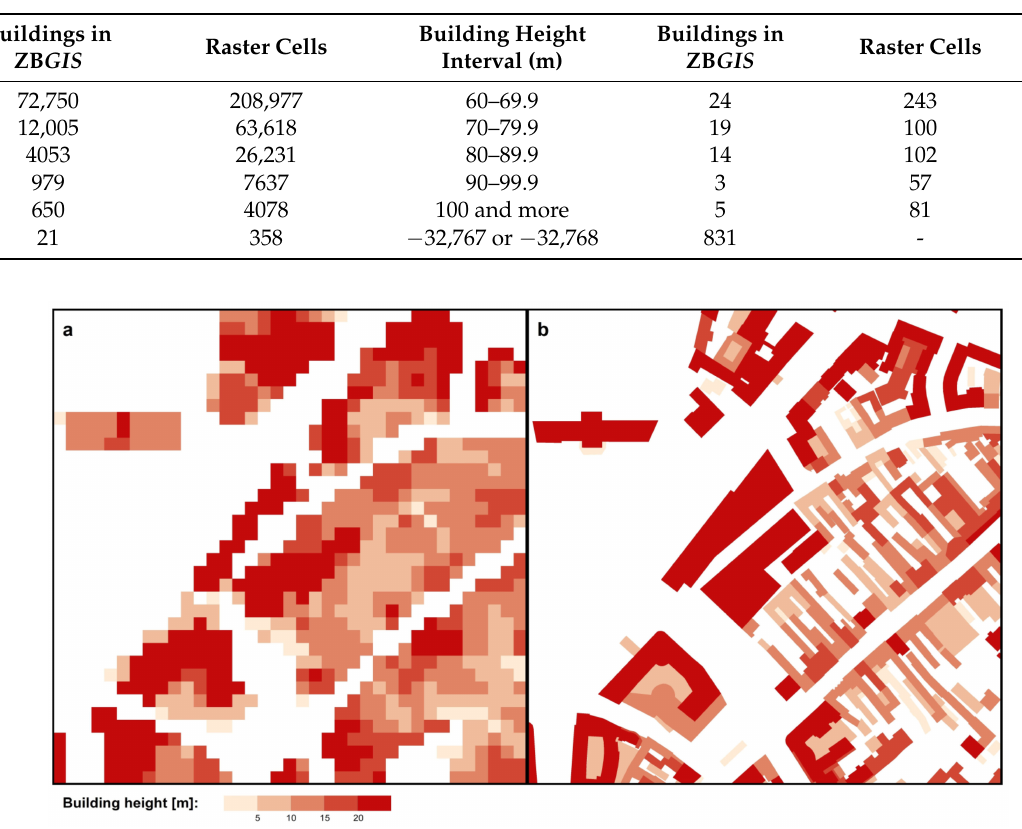
Figure 2. Comparison of the ( a ) BH2012 raster layer and the ( b ) ZB GIS subcategory